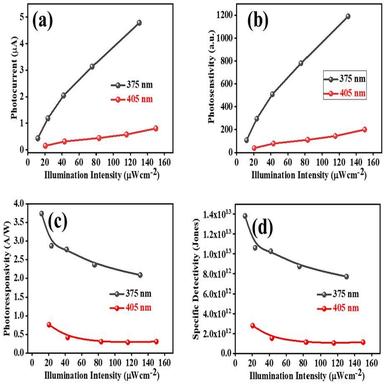
Illumination intensity dependent photoresponse of the photodetector in terms of (a) photocurrent, (b) photosensitivity, (c) photoresponsivity, and (d) and specific detectivity.